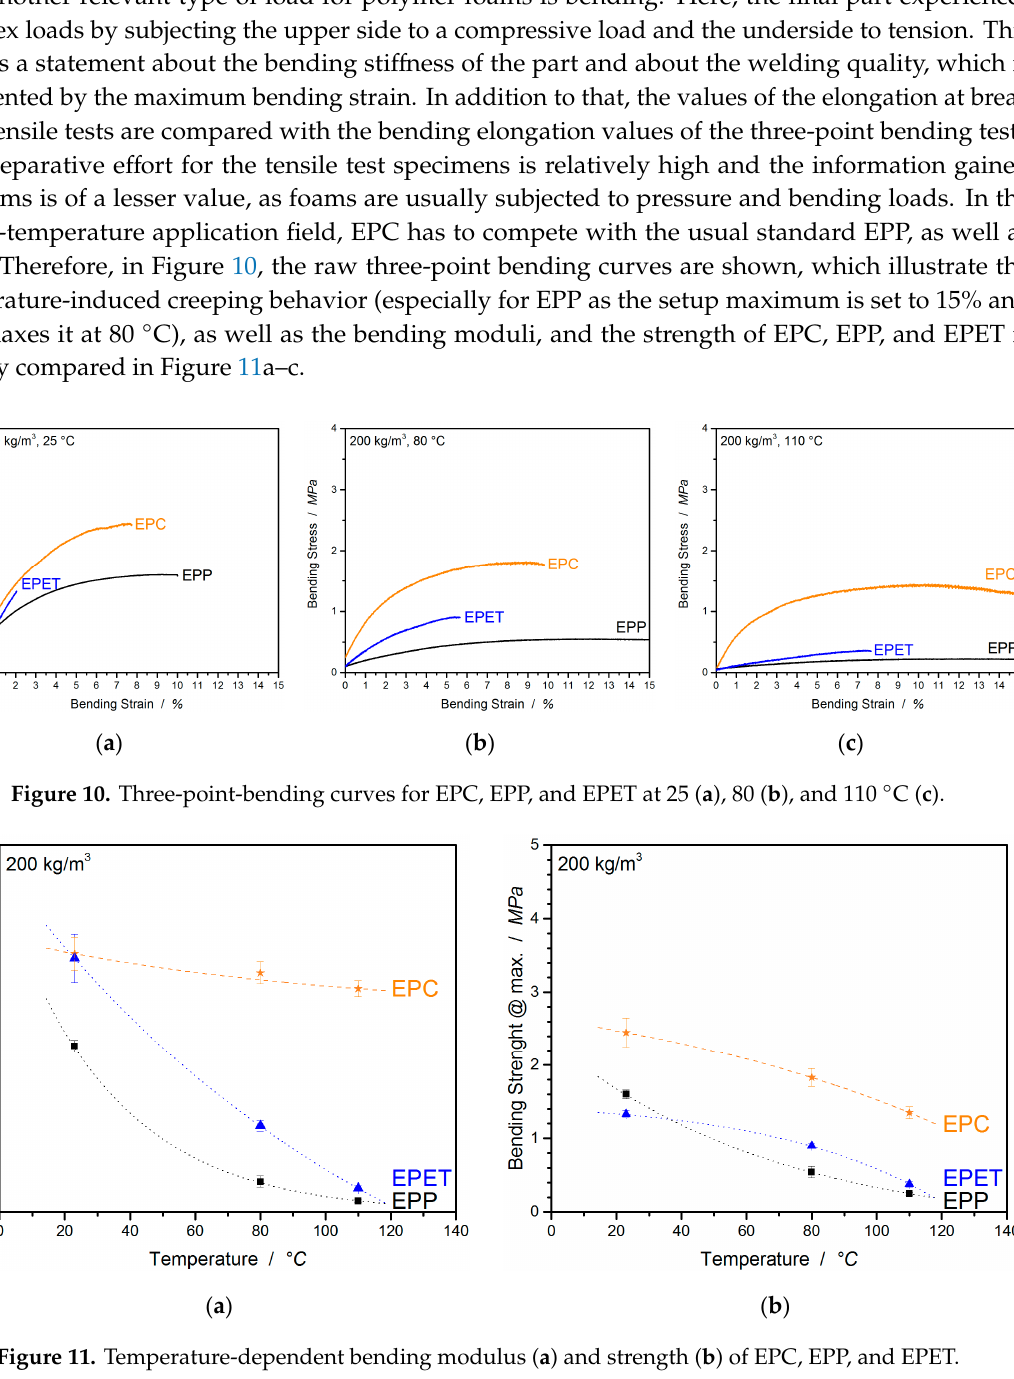
Figure 11. Temperature-dependent bending modulus ( a ) and strength ( b ) of EPC, EPP, and